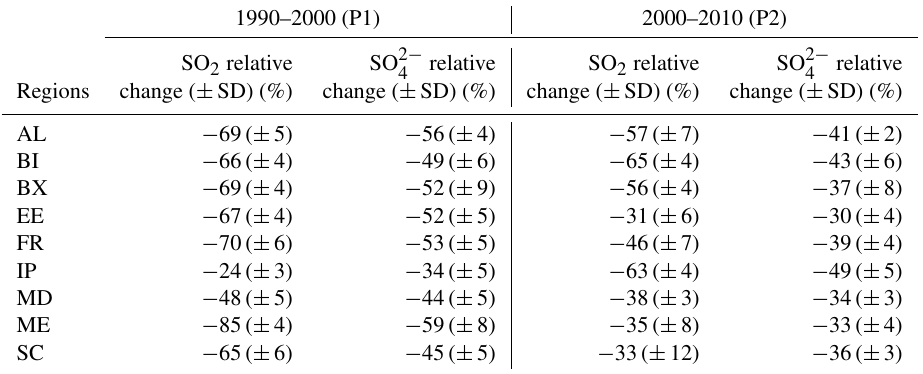
Table 6. Means and standard deviations of the modeled relative changes in SO 2 and SO 2 − (2000–2010) periods for all the PRUDENCE regions (Fig. 1).